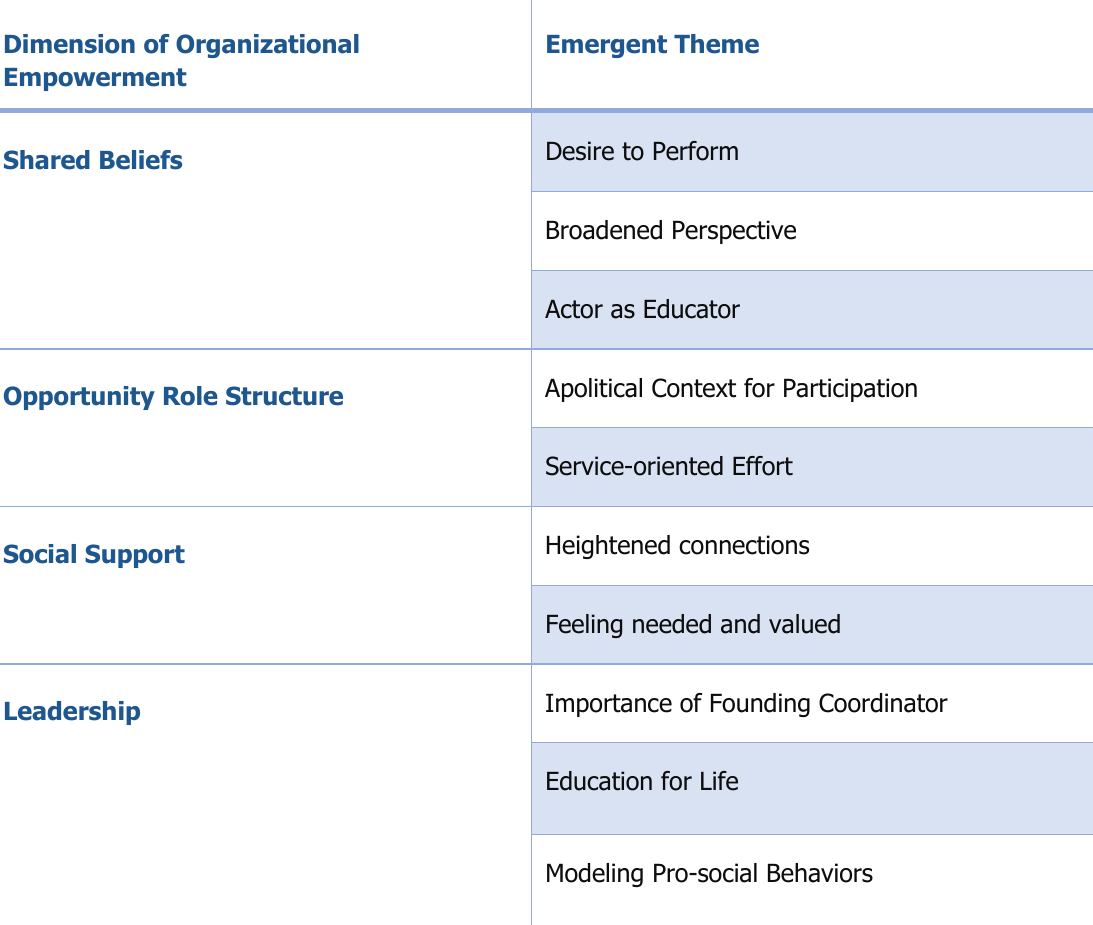
Table 2. Summary of Qualitative Findings by Theme and Subtheme Dimension of